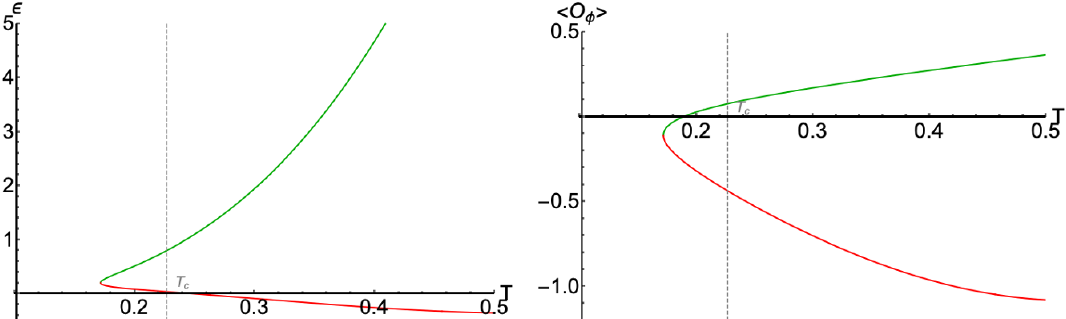
Figure 14 . The energy (left) and expectation value of the dual operator to the scalar (cid:12)eld (right) of the dual boundary theory corresponding to the class C